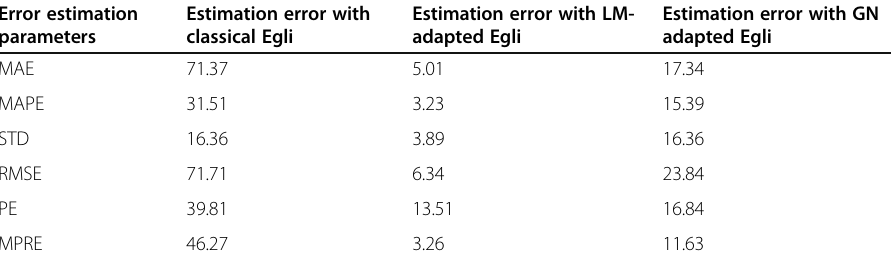
Table 4 Computed first order estimates statistics for Cell_2 Error estimation